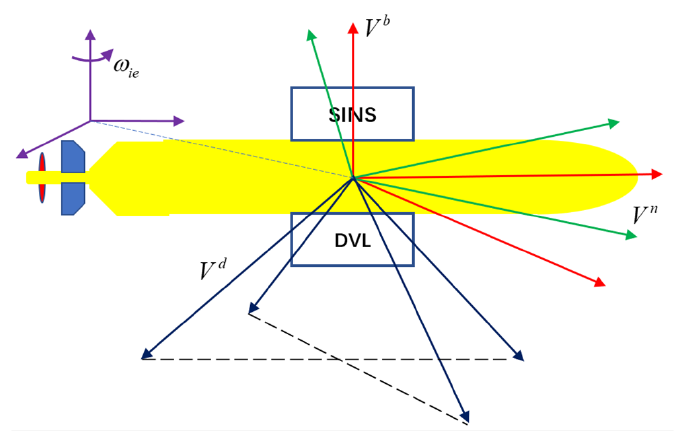
Figure 2. Schematic diagram of each reference coordinate frame. The green line represents the navigation coordinate frame, the red line represents the carrier coordinate frame, and the blue line represents the DVL device coordinate frame.